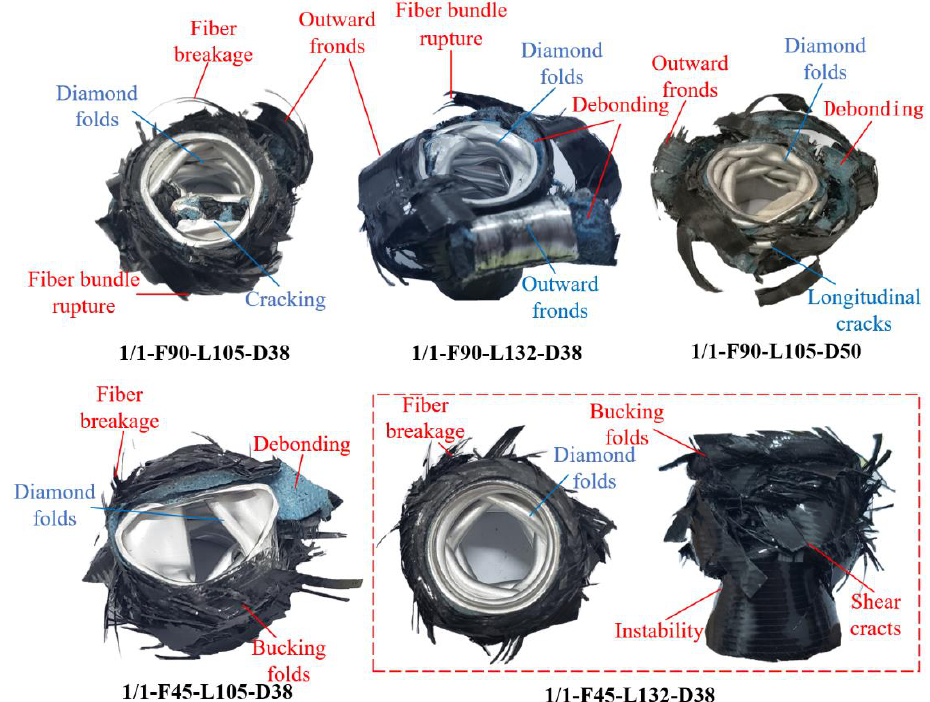
Figure 9. Final failure modes of 1/1 hybrid tubes with two lay-up sequences.